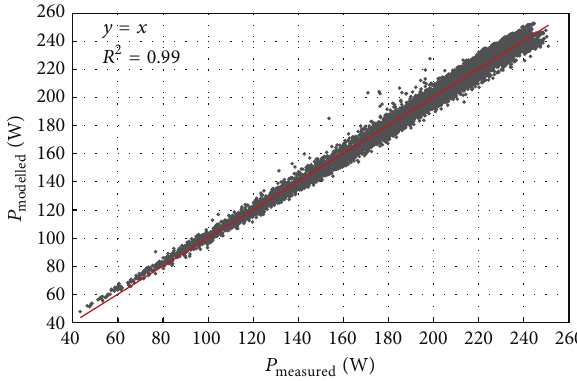
Figure 5: Linear regression analysis between measured and pre- dicted data for the proposed model for the HCPV